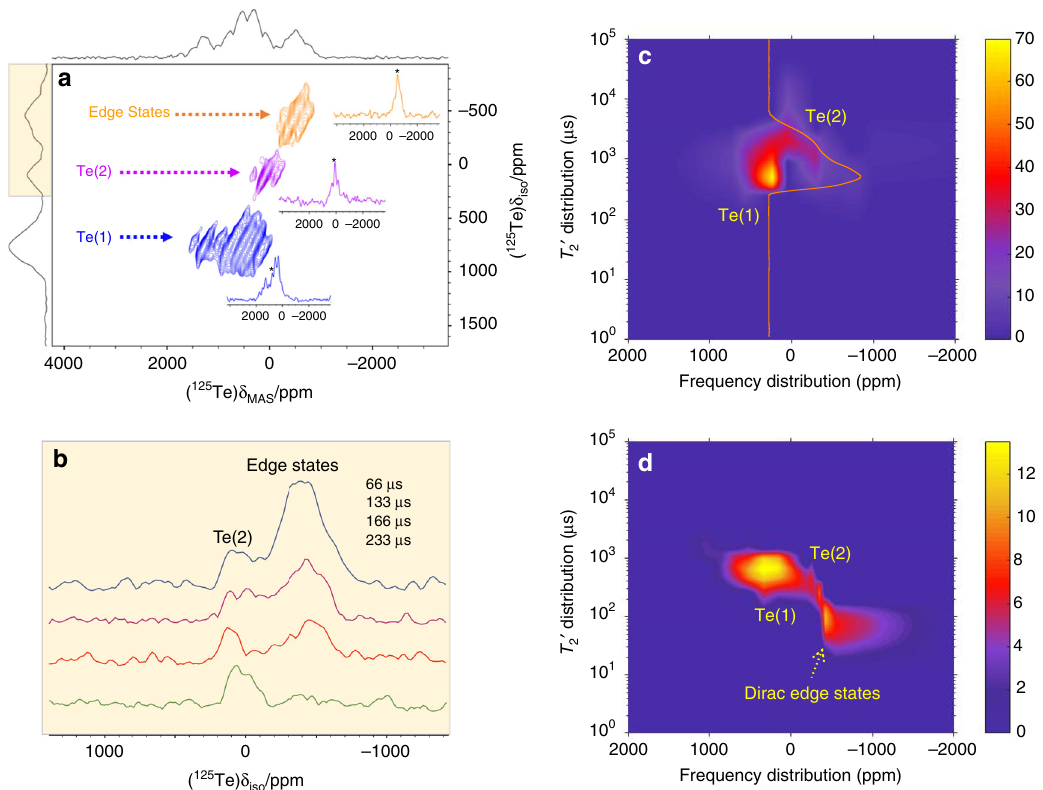
Fig. 3 125 Te aMAT NMR and T 0 dephasing analysis of the Dirac edge states. a 2D 125 Te aMAT NMR spectrum of Bi 2 Te 3 nanoplatelets. Blue and magenta 2 color contours indicate signals from the bulk interior of the nanoplatelets, while the orange color contours show signals from the surface Te sites, shielded by the orbital motion of the Dirac electrons. b The expanded isotropic projections of 125 Te MAT NMR spectrum acquired at four different evolution times. distribution as a function of the resonance frequency of microcrystalline (bulk) Bi 2 Te 3 . The orange color cross section shows the T 0 c The 125 Te NMR T 0 2 distribution at frequency 250 ppm. d The 125 Te NMR T 0 distribution with respect to the resonance frequency of the Bi 2 Te 3 2